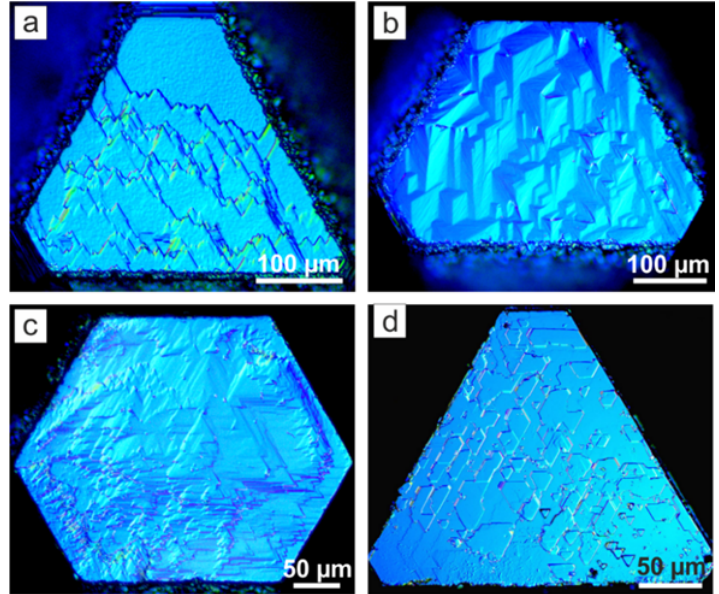
Figure 3. Optical micrographs (di ff erential interference contrast (DIC) method) of the {111} faces of diamond seed crystals from experiments in molten europium salts: ( a ) run ES-8; ( b ) run ES-6; ( c ) run ES-12; ( d ) run ES-10.